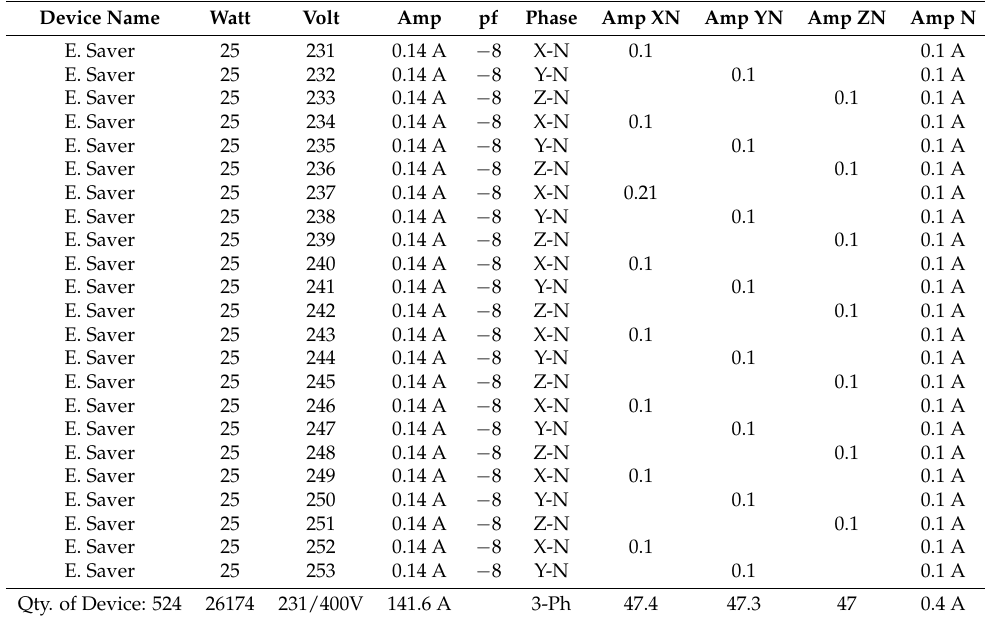
Table 14. Academic Block proposed load data